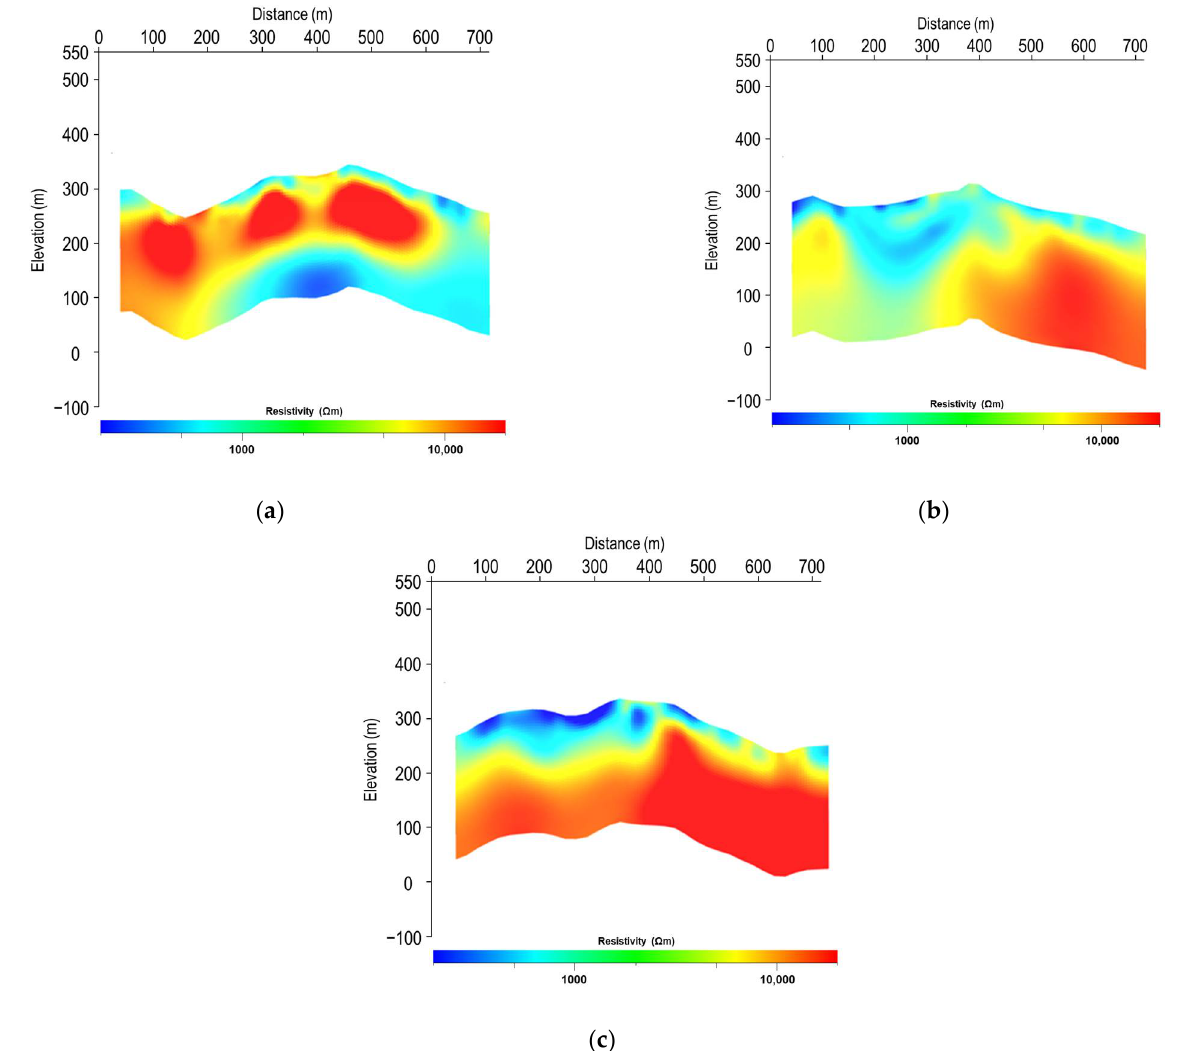
Figure 4. Two-dimensional inversion results of electrical resistivity for ( a ) survey line 1, ( b ) survey line 2, and ( c ) survey line 3. The axis showing distance starts from the